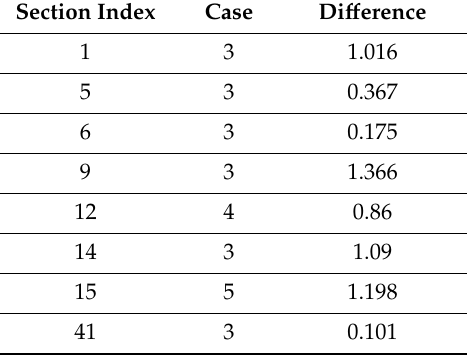
Table 4. Di ff erences between critical depths computed with ACPA and HEC-RAS for dataset 4. Section